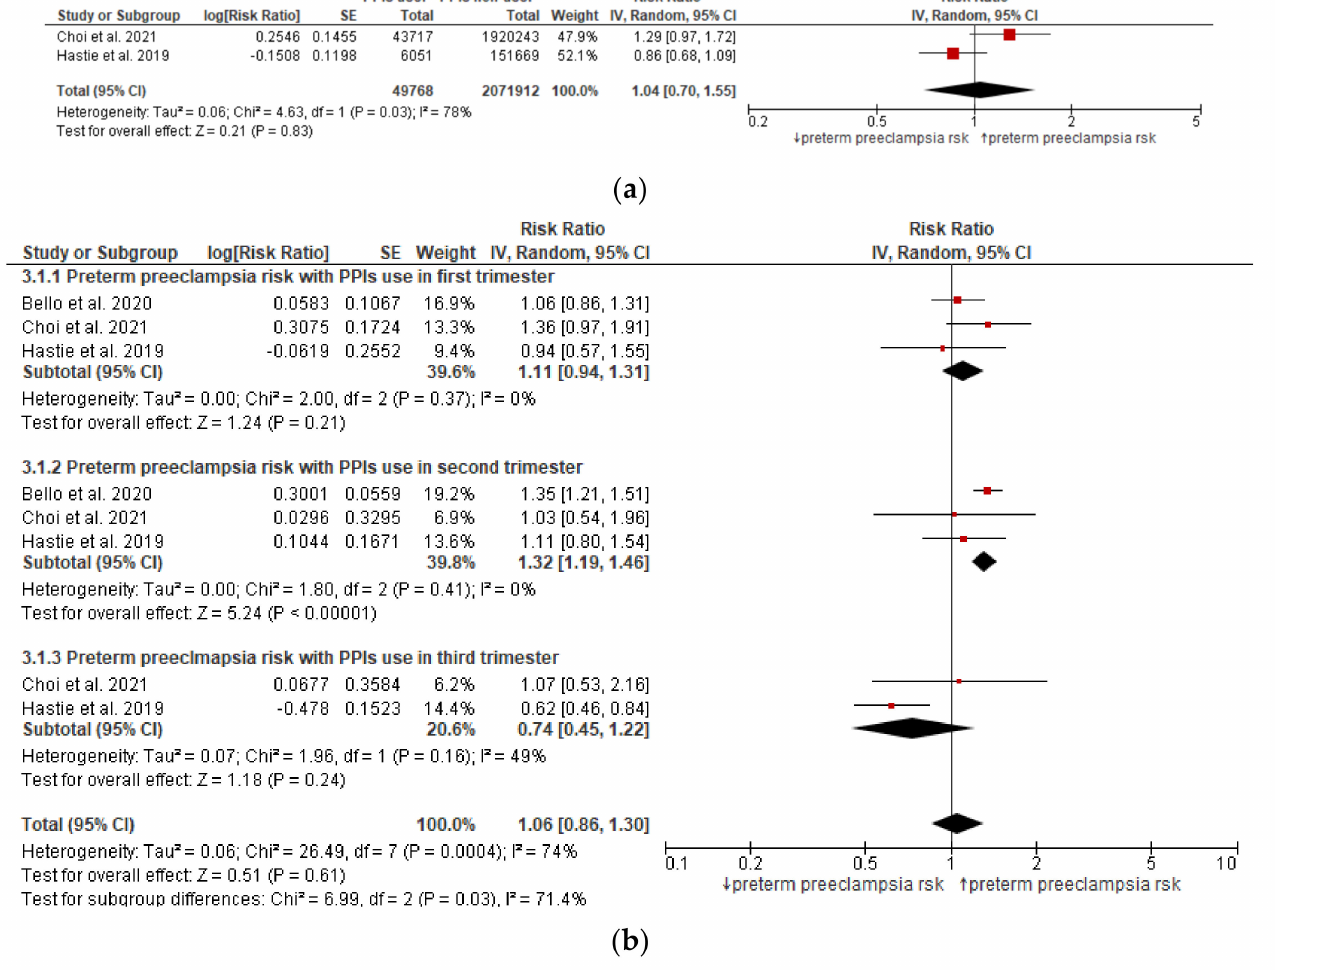
Figure 3. ( a ) Preterm preeclampsia risk in women exposed to PPIs anytime during pregnancy. ( b ) Preterm preeclampsia risk in women exposed to PPIs in different trimesters of